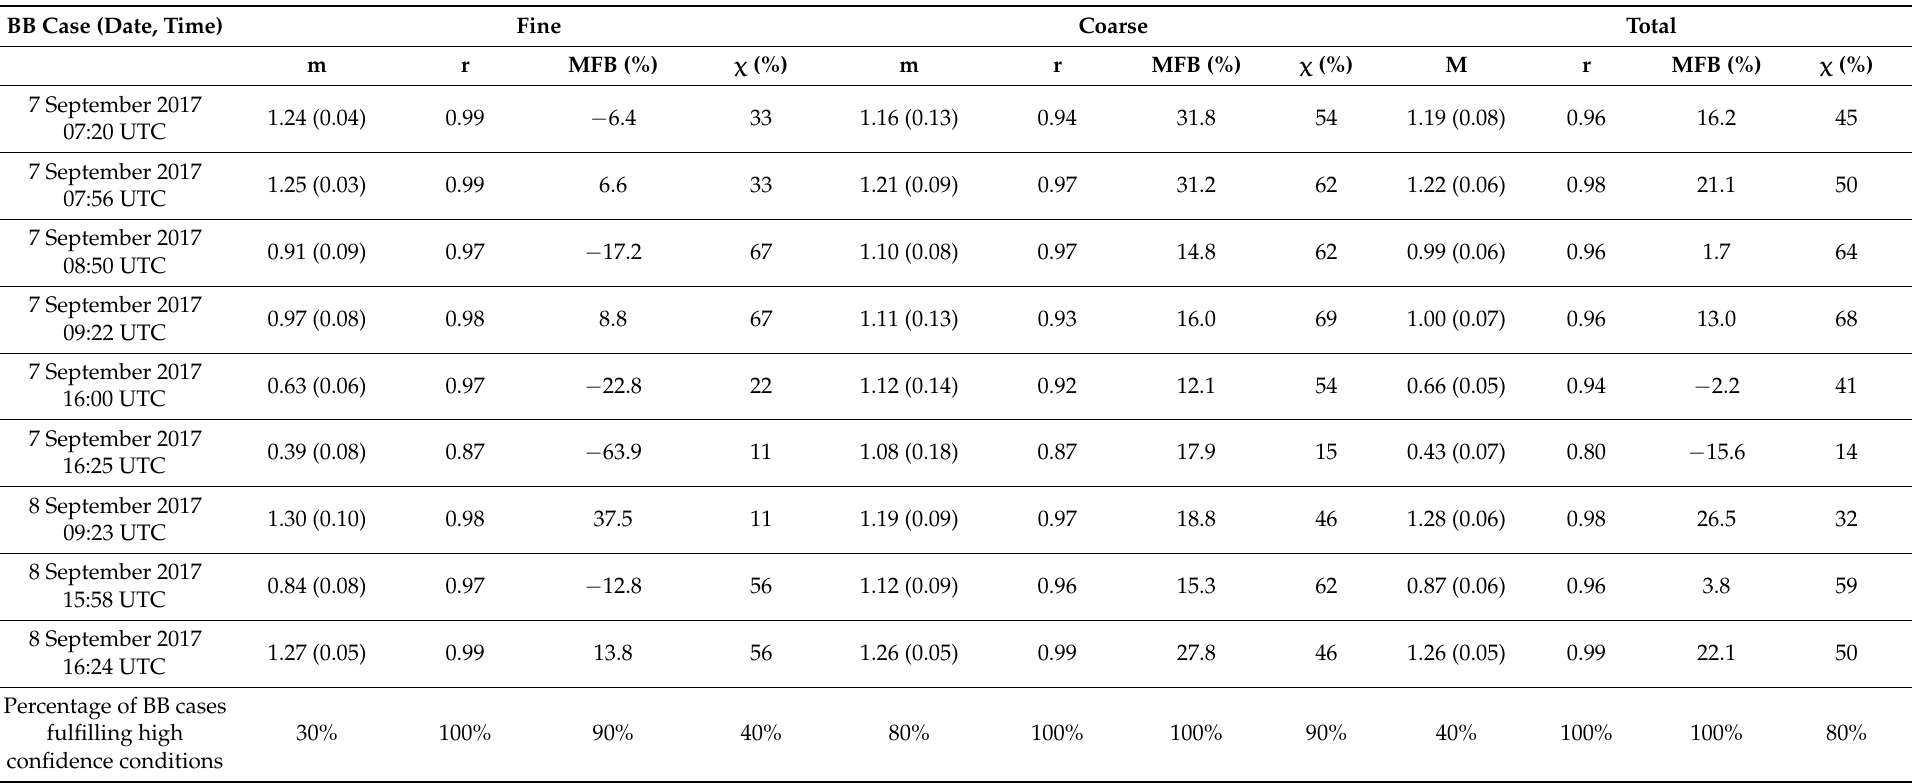
Table 3. Mean statistical parameters of the comparisons of GRASP vs. AERONET retrievals for the fine (particle radius < 0.5 µ m) and coarse (particle radius ≥ 0.5 µ